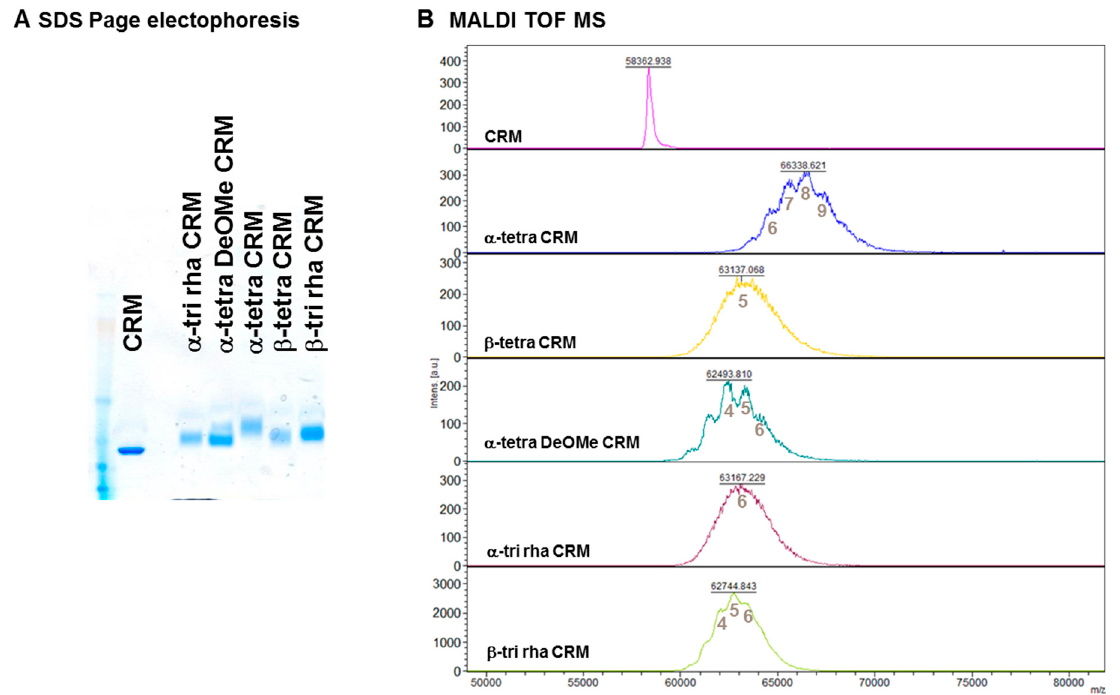
Figure 4. ( A ) SDS-PAGE (8–12%) and ( B ) MALDI-TOF MS spectra of synthesized glycoconjugates.